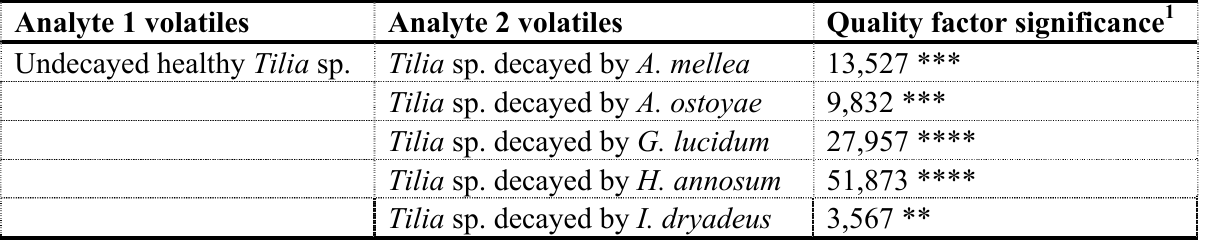
Table 7. Three-dimensional PCA pair-wise comparison of headspace volatile metabolites released from Tilia sp. wood blocks decayed by different wood decay fungi ( Armillaria mellea , A. ostoyae , Ganoderma lucidum , Heterobasidion annosum , Inonotus dryadeus ) relative to undecayed healthy (control) wood blocks. Undecayed healthy Tilia